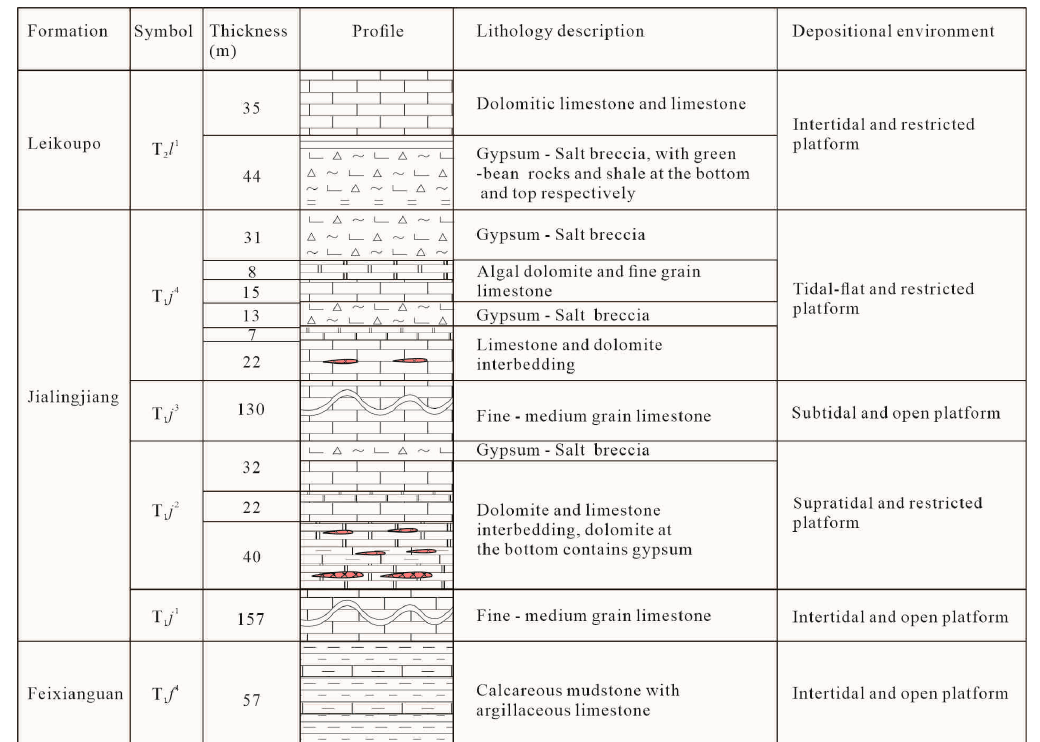
Figure 3. Geological section of the southeast lamb of the Xishan anticline. The location of the section is shown in Figure 2.